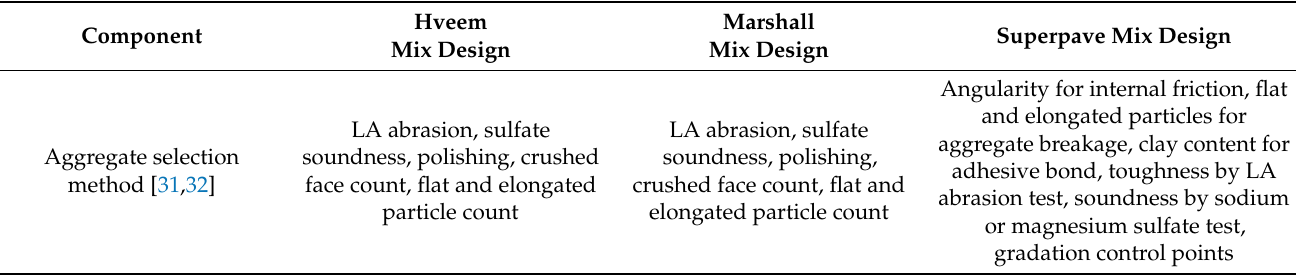
Table 1. Comparison of asphalt mix designs currently used in the